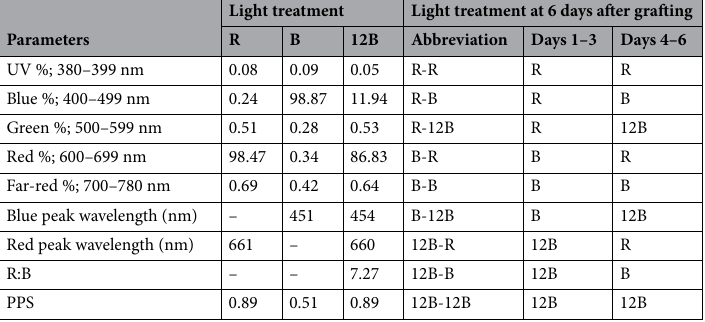
of 30 cm from plant top which allowed us to irradiate the seedlings with the aforementioned PPFD. Specifi- cally, LEDs emitted narrow-band red (R), narrow-band blue (B), and RB with 88% red and 12% blue (12B). 12B proved valuable for grafted watermelon seedlings’ quality in another study of our group 20 . Spectral parameters were obtained with a spectroradiometer (HD 30.1 spectroradiometer, DeltaOhm Srl, Padova, Italy) and are presented in Table 1. The abovementioned light conditions applied for three days after grafting. At that point, two trays from each light treatment switched places with trays from the other two light treatments, while one tray remained in its initial light treatment leading to a total of 9 light treatments presented in Table 1. The trays remained in their final position for three more days (six days of healing in total) until exiting the healing chamber. Sampling and measurements. Relative chlorophyll content (measured with CCM-200 plus, Opti-Sci- ences, Hudson, NH, USA) and chlorophyll fluorescence measurements (measured with pocket plant efficiency analyzer, Hansatech, King’s Lynn, UK) were conducted in situ at several time intervals after a minimum of